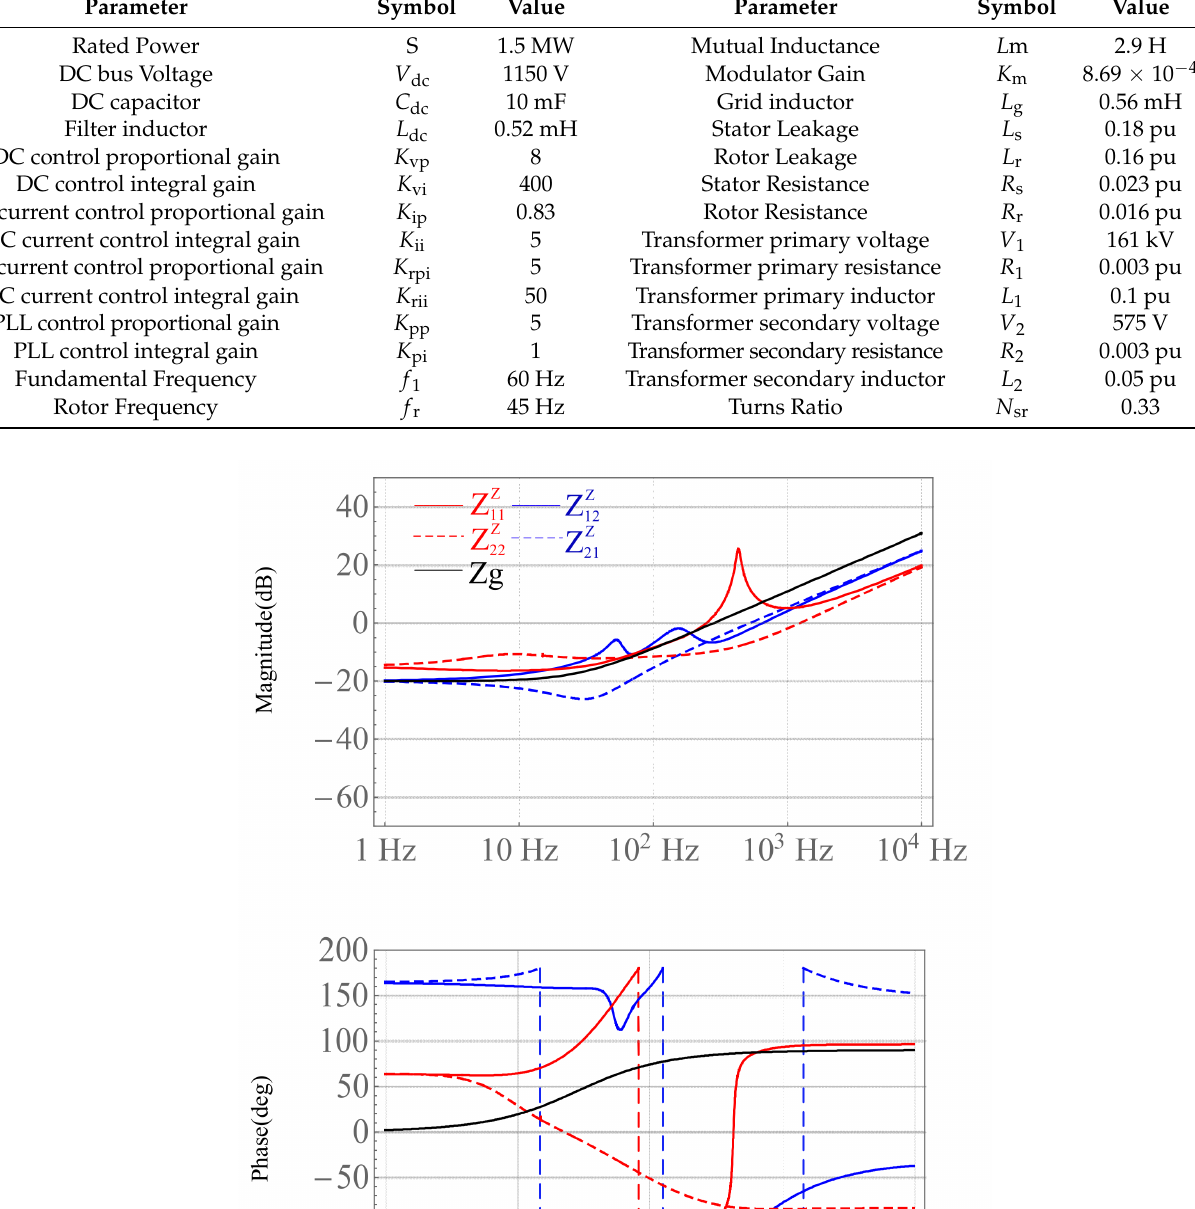
Table 1. DFIG system simulation parameters.